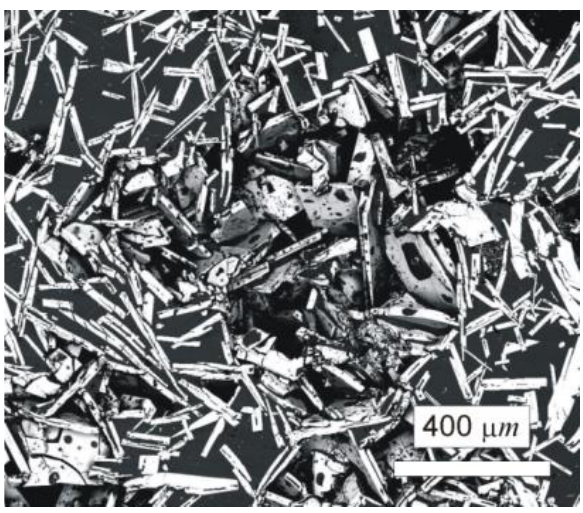
Figure 7. Shrinkage in the upper part of the W – Al-VIM-1 alloy.